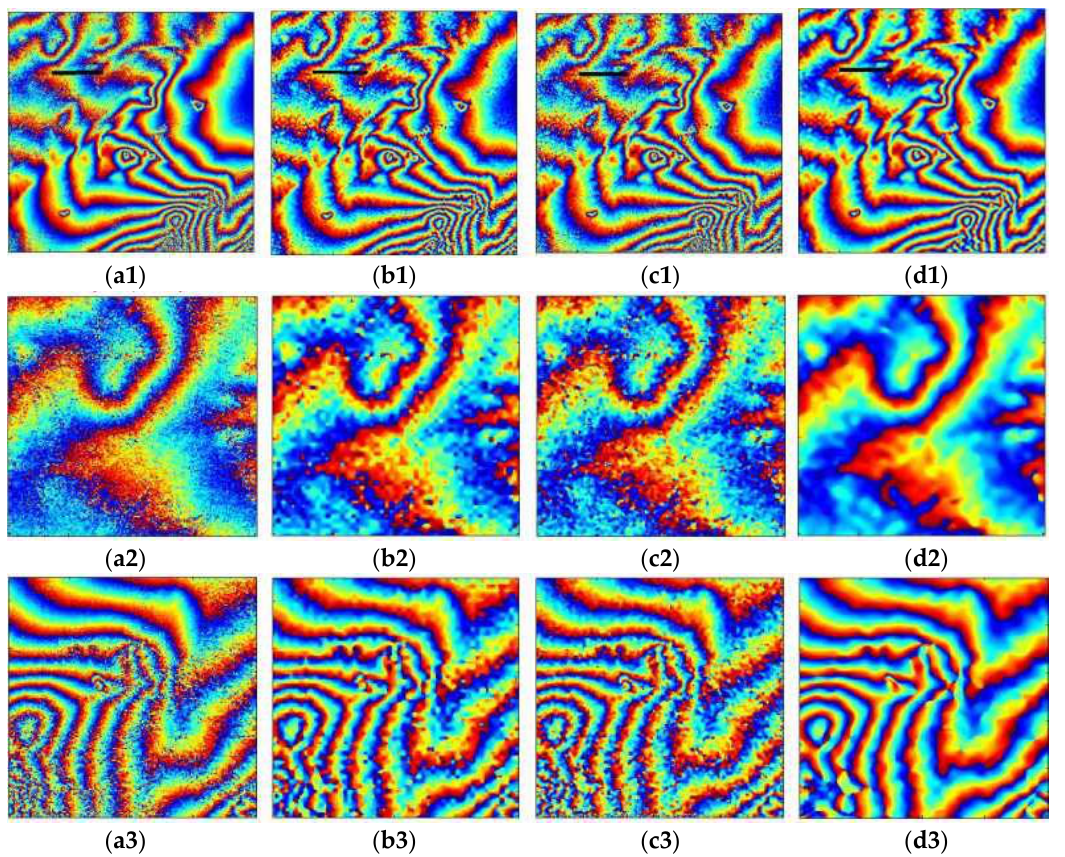
Figure 5. Filtered results of simulated data with ( a1 ) Goldstein; ( b1 ) wavelet; ( c1 ) Lee; ( d1 ) the proposed method; ( a2 – d2 ) Close-up of results of area A in Figure 4; ( a3 – d3 ) Close-up of results of area B in Figure 4; the black line in ( a1 – d1 ) indicates the extracted section. (Unit: rad).